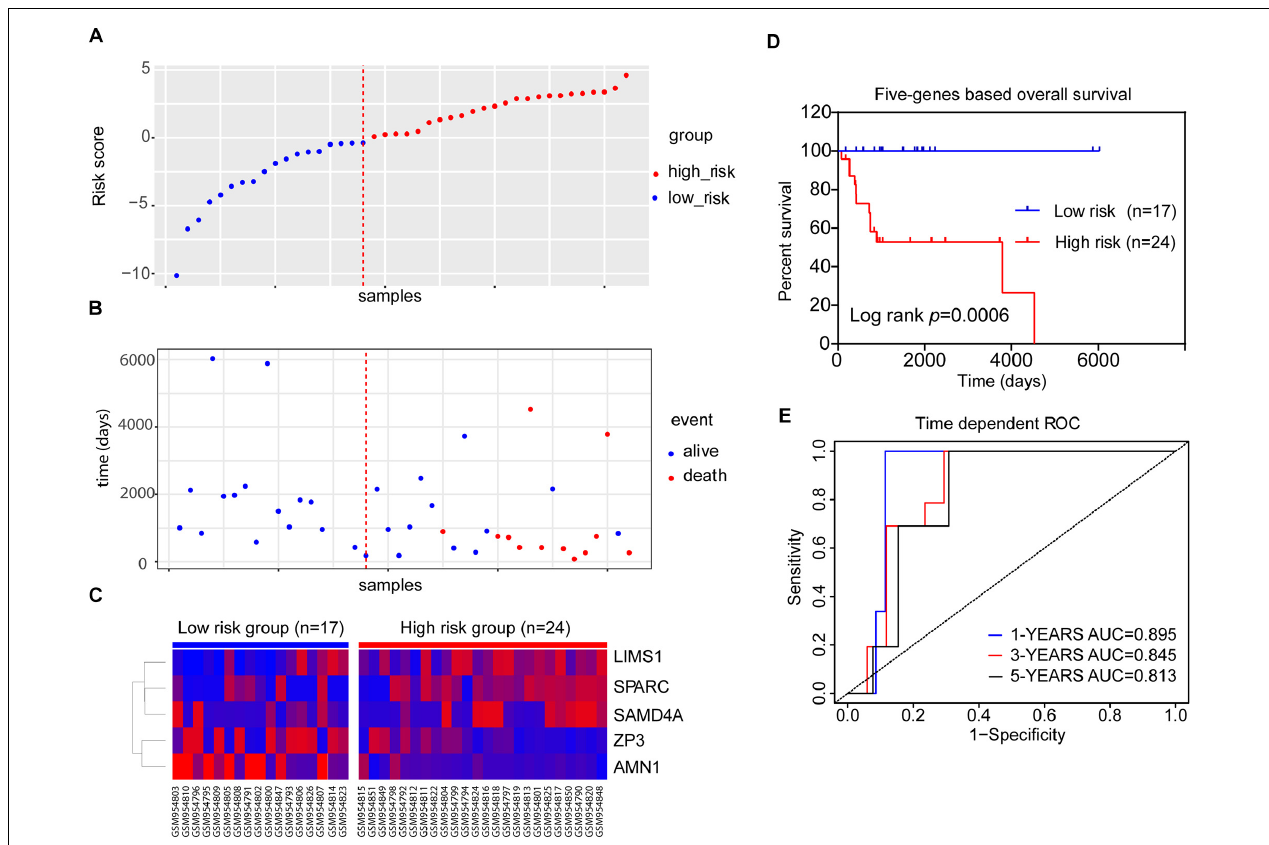
FIGURE 4 | The five-gene risk score model for the GSE39058 dataset ( N = 41). (A) Scatter plot displaying the risk score of each patient in the GSE39058 dataset. Patients were divided into high- or low-risk groups according to the risk score. The blue plots represent the patients in the low-risk group (risk score ≤ 0), while the red plots represent patients in the high-risk group (risk score > 0). (B) The survival status distribution of patients with osteosarcoma in the high- or low-risk groups. (C) The expression status of the five prognostic genes in 41 patients with osteosarcoma in the GSE39058 dataset. (D) K–M survival curves showing the difference in OS between high- and low-risk patients (41 patients) (log-rank test, p = 0.0006). (E) Time-dependent ROC curve analysis for the prediction of survival using the five-gene prognostic model. The AUCs of 1-, 3-, and 5-year OS are shown in the figure. AUC, area under the curve; K–M, Kaplan–Meier; OS, overall survival; ROC, receiver operating